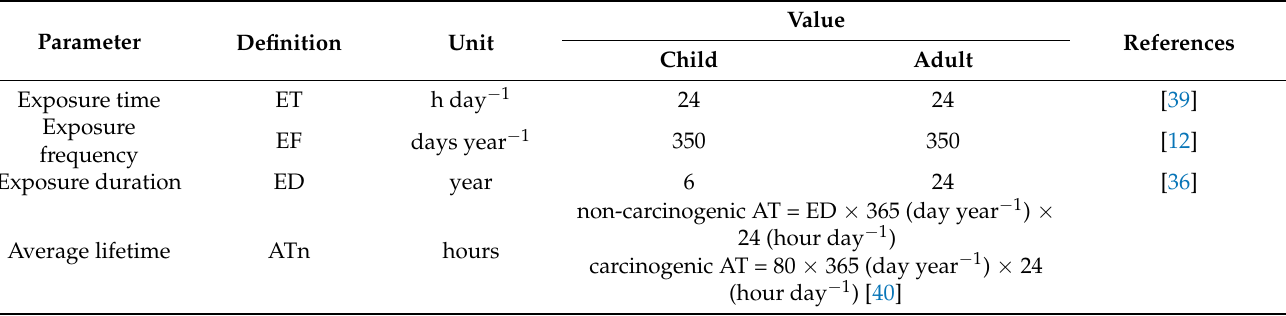
Table 1. Parameters and values used in the human health